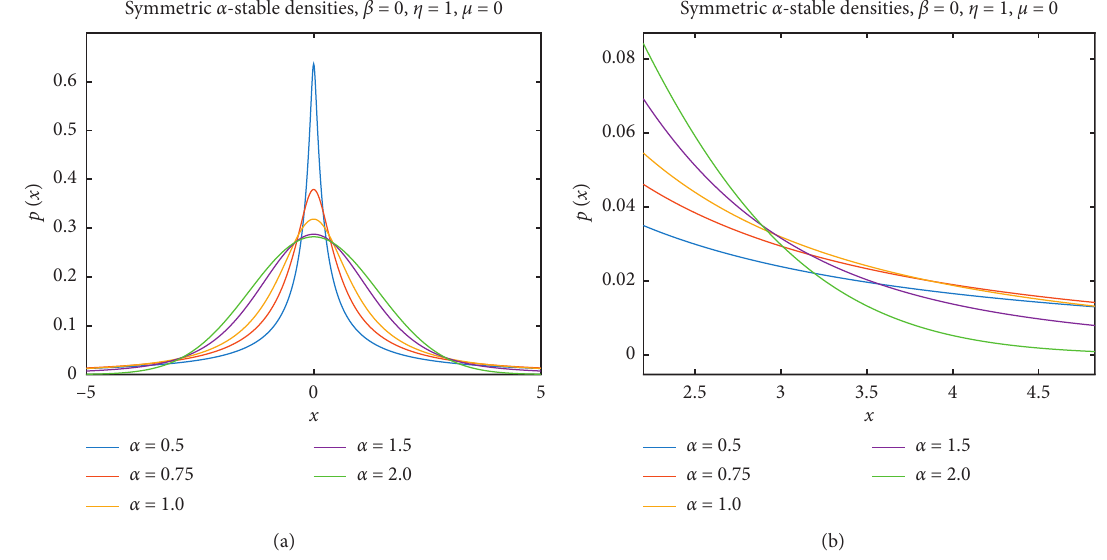
Figure 3: Probability density functions for alpha-stable distributions: (a) the overall shape and (b) the